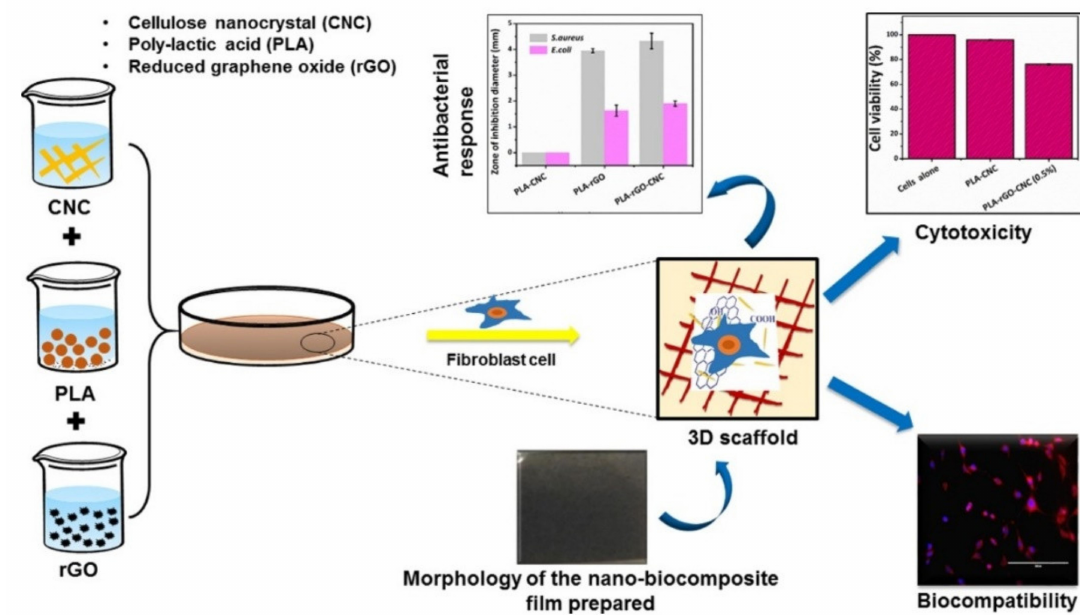
Figure 9. Schematic description of the method used for the preparation of nanocomposite films ( left ); Antibacterial properties, cytotoxicity, biocompatibility, and morphology of the PLA / CNC-rGO composites ( right ) [61]. Reproduced with copyright